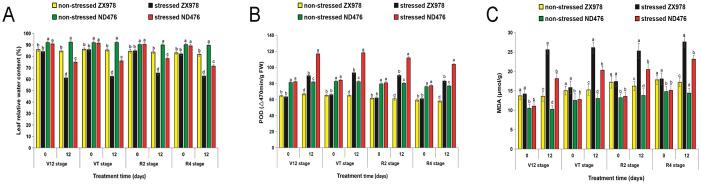
Physiological responses of ND476 and ZX978 maize hybrid cultivars to a 12-day drought treatment exposure at various growth stages.(A) Leaf RWC (B) POD activity and (C) MDA content. Data are presented as means ±SE (n = 3). Different letters above bar graphs show significant difference (p < 0.05) among treatments at a given treatment time point.